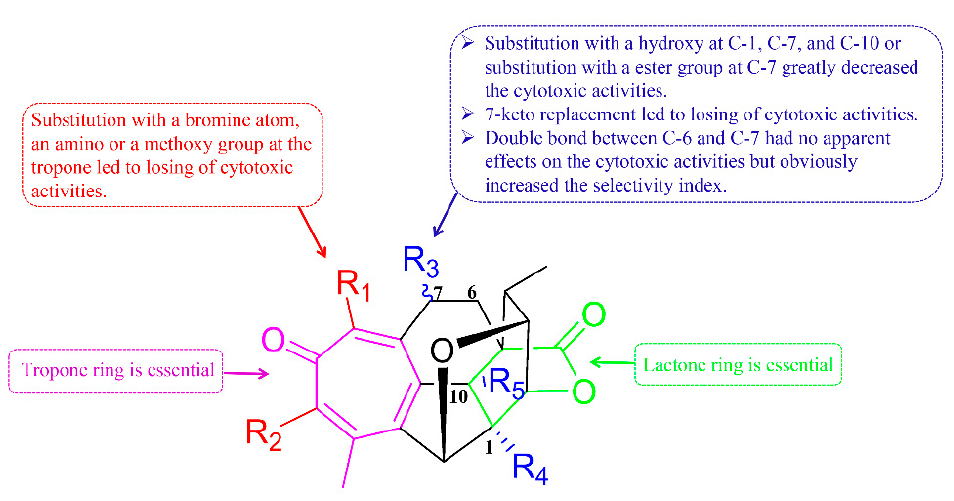
Figure 2. Systematic structure − activity relationship (SAR) of harringtonolide (HO) derivatives.